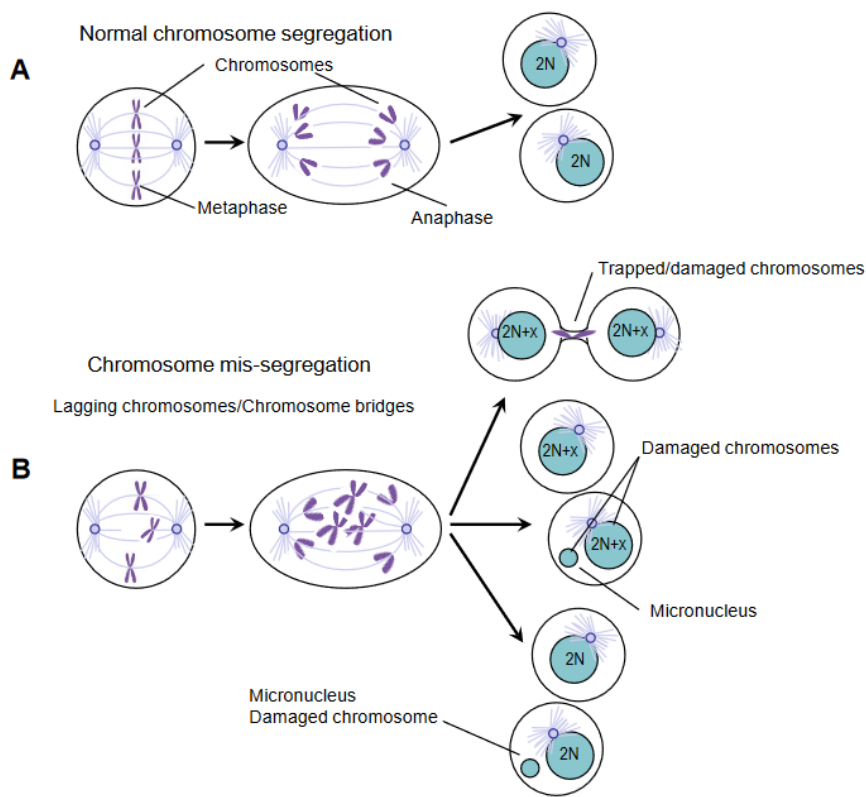
Figure 1. Chromosome mis-segregation causes DNA damage. ( A ) Precise chromosome segregation leads to the equal partitioning of the genome and the generation of two euploid daughter cells with diploid karyotype (illustrated as 2N). ( B ) Defective chromosome segregation can have multiple fates. Chromosomes can be trapped in the cytokinetic furrow and break during cytokinesis ( top ). Alternatively, chromosomes can mis-segregate and form micronuclei ( middle ), or they can be accurately segregated in nucleus/micronucleus in the daughter cells ( bottom ). Irrespective of how micronuclei are generated, their DNA is significantly damaged and elicits a DNA damage re- sponse.